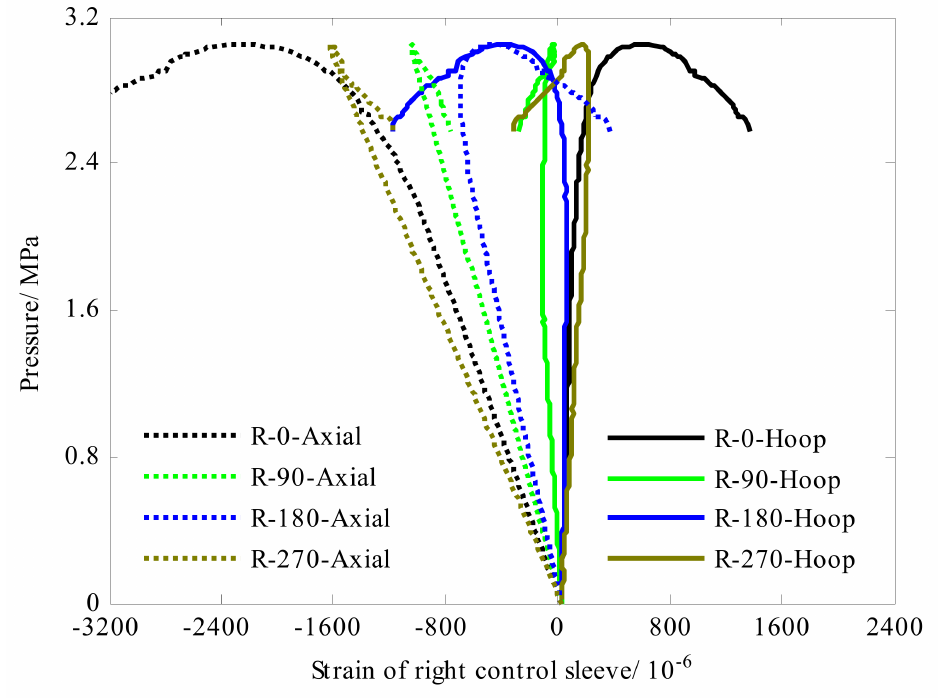
Figure 7. Strain response of the right control sleeve of cylinder